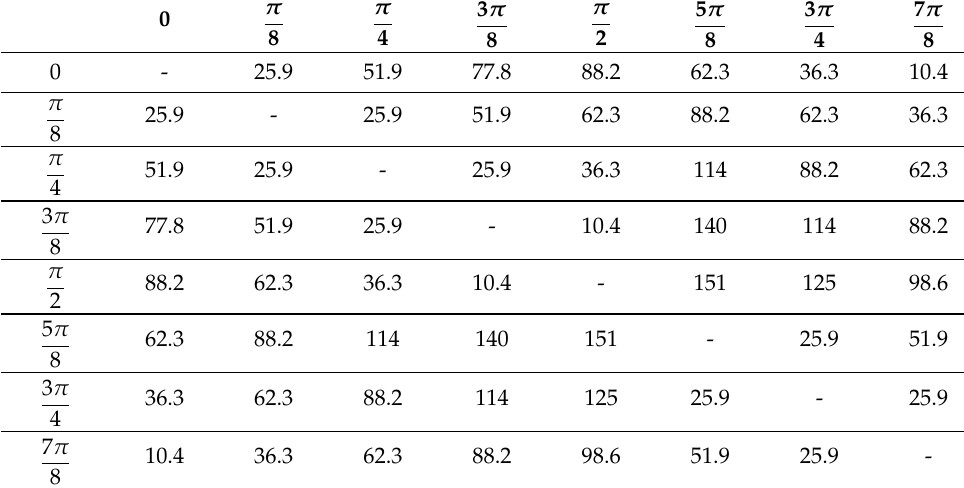
Table 12. Time difference in Days at peak between a microlensing photometric curve with Φ shown in the first row, compared to the photometric curve with Φ in the first column. Error values for R = 1 AU. Values in bold underline show where % error between the two curves is less than 5%.